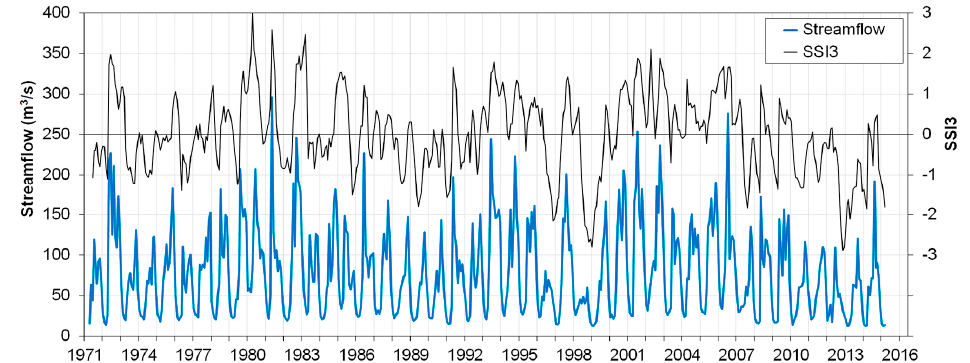
Figure 4. Temporal evolution of monthly streamflow (red line) and monthly SSI3 (black line) for the Agrio river (2010 station) over the period July 1971–June 2016.